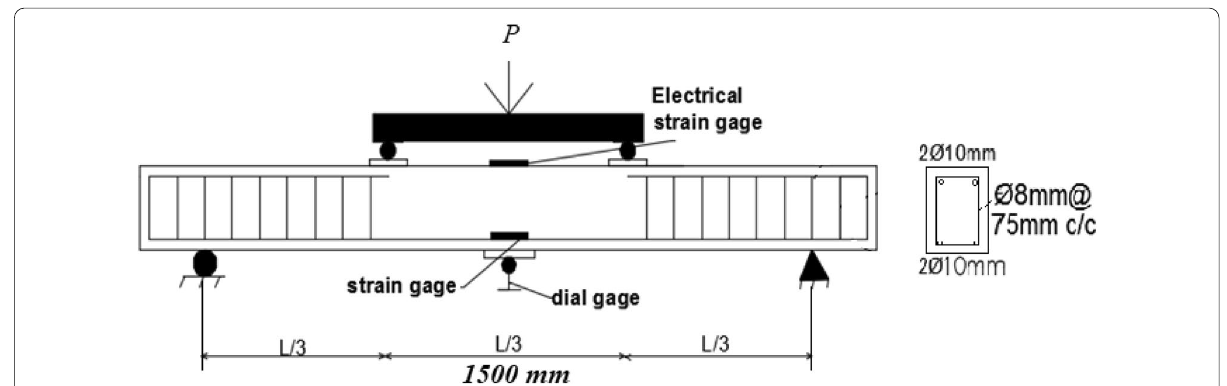
Fig. 4 Test setup and beam details.